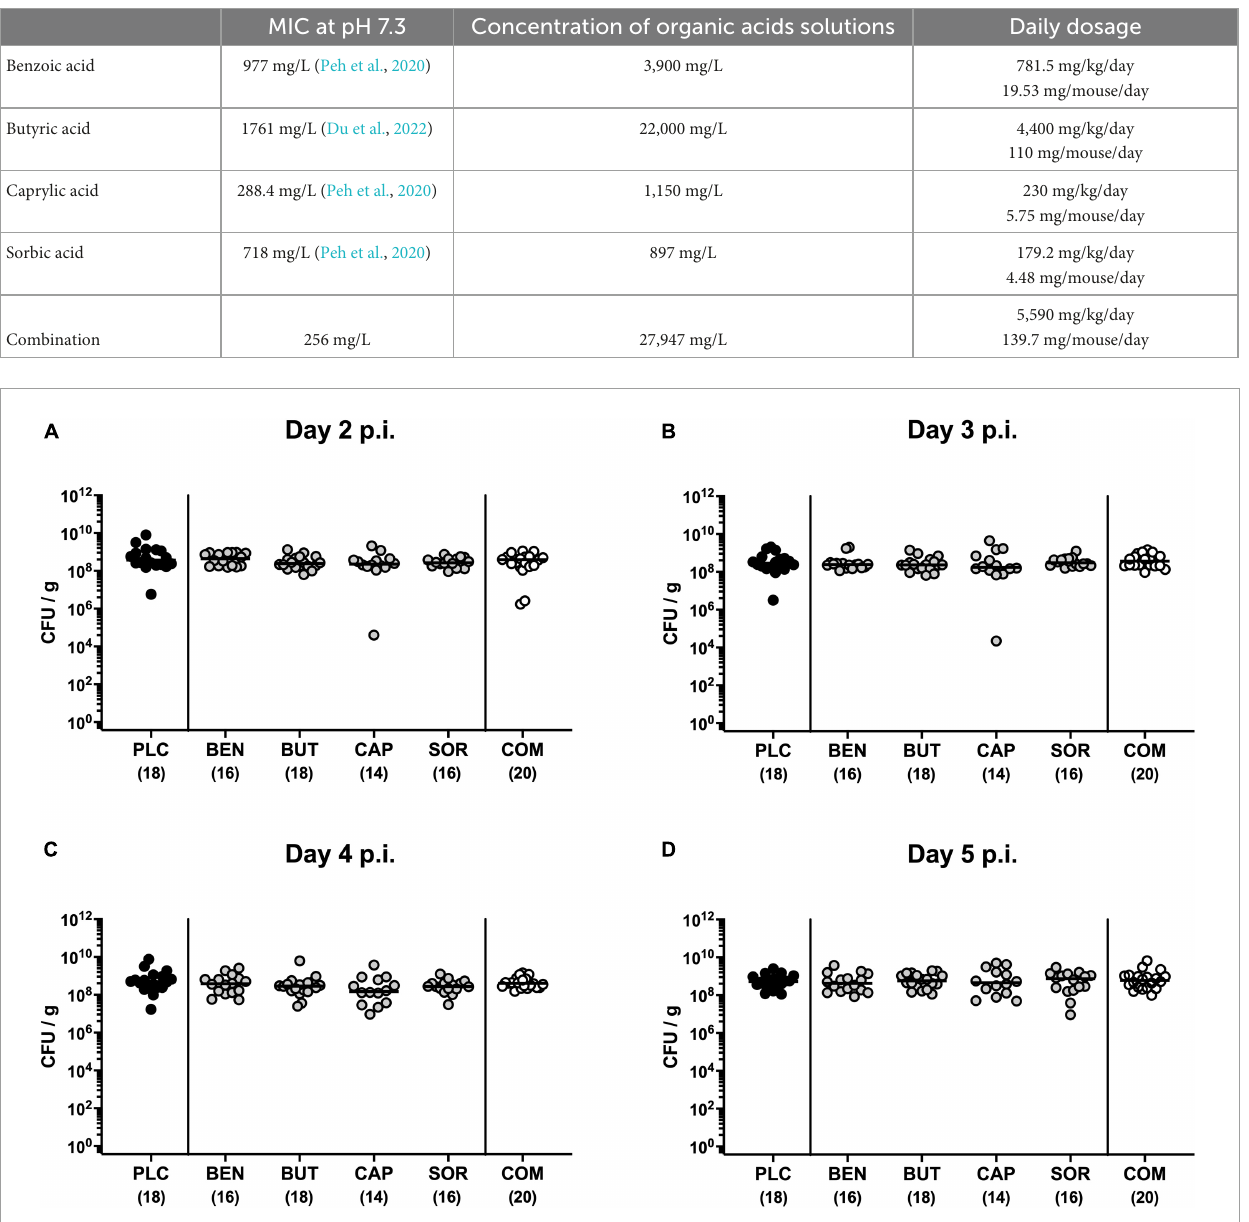
TABLE 1 Minimum inhibitory concentrations (MICs) and concentrations of applied drinking solutions for benzoic acid, butyric acid, caprylic acid, and sorbic acid (alone and all combined).